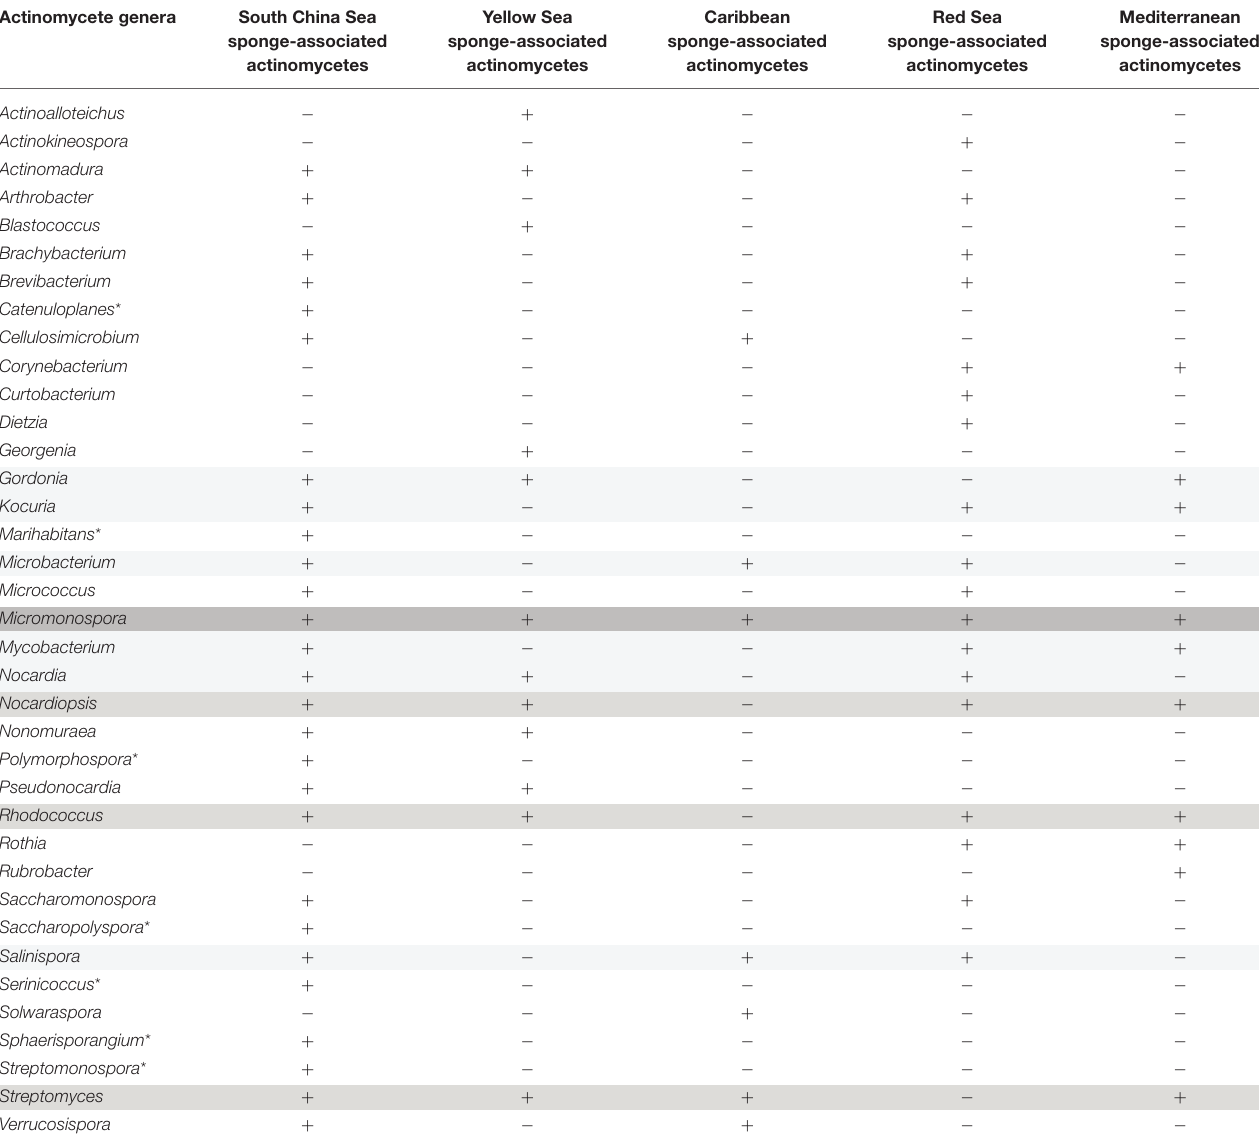
TABLE 5 | Comparison of the culturable diversity of the sponge-associated actinomycetes from the South China Sea, Yellow Sea, Caribbean Sea, Red Sea, and Mediterranean Sea. Actinomycete